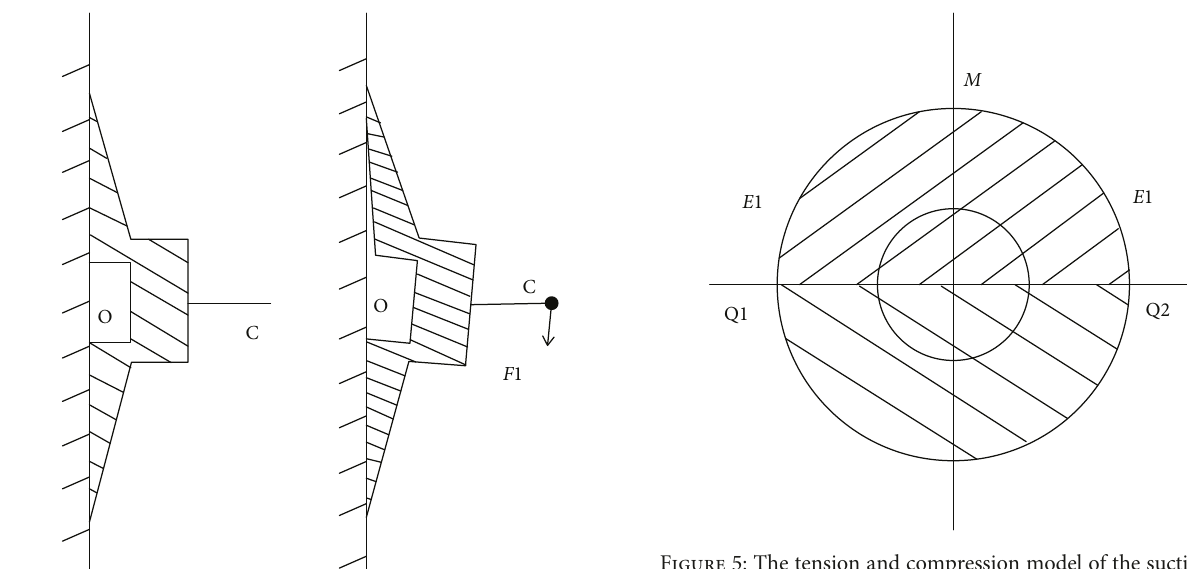
Figure 5: The tension and compression model of the suction cup.